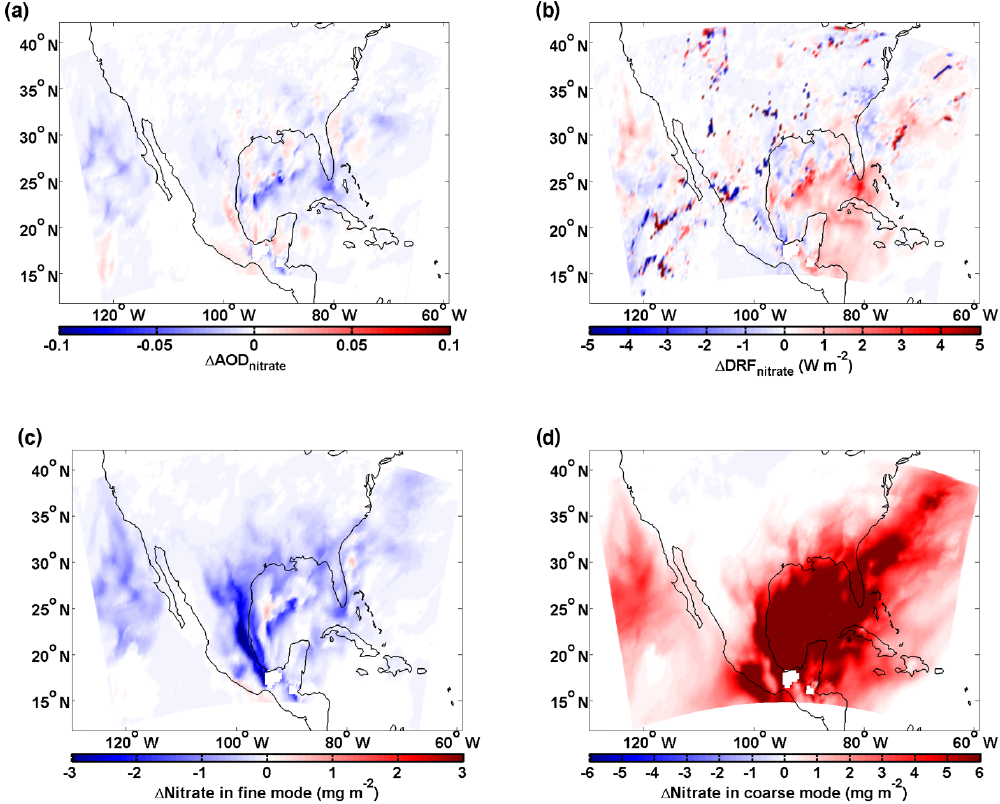
Figure 8. Influence of sea-salt aerosol on the abundance and direct radiative forcing of nitrate (similar to Fig. 5). (a) Differences (Case_ SeasaltOn – Case_SeasaltOff) between simulations with and without sea-salt emission in aerosol optical depth ( (cid:49) AOD nitrate ), (b) direct radiative forcing ( (cid:49) DRF nitrate ) and column loading of nitrate ( (cid:49) Nitrate) for the (c) fine- and (d) coarse-mode particles. The modeled results shown here are averaged during daytime over the North American domain, i.e., 16:00–22:00 (UTC) on 10–17 January